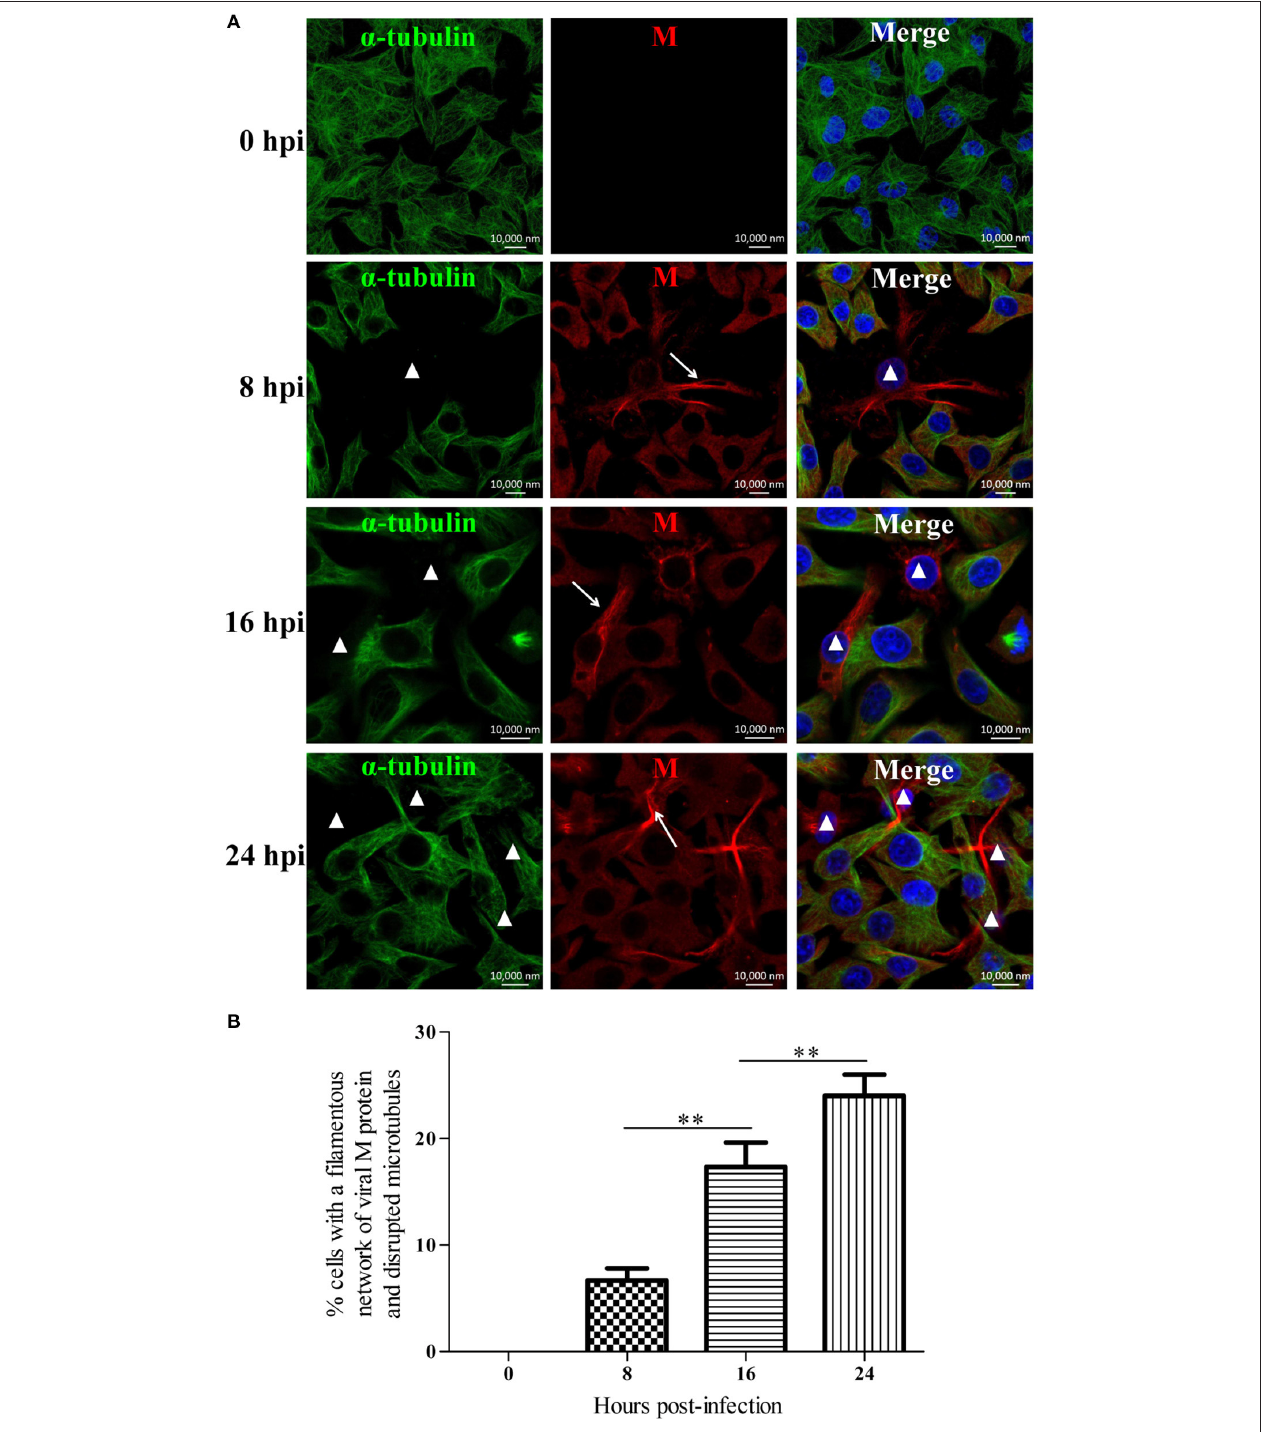
FIGURE 1 | RABV infection damages the host microtubule cytoskeleton. (A) N2a cells were infected by RABV at an MOI of 1 for 0, 8, 16, or 24h. Subsequently, the cells were fixed, permeabilized, and incubated with the anti- α -tubulin antibody (green) and anti-RABV-M antibody (red). The nuclei (Nuc) were stained with DAPI (blue). The cells were analyzed using a laser scanning confocal microscopy. The white arrows represent the filamentous network of viral M protein in RABV-infected cells and the white triangles indicate the cells which have a filamentous network viral M protein and disrupted microtubules. Scale bars, 10,000 nm. (B) Three random microscopic fields having at least 50 cells each were chosen to calculate the number of cells with a filamentous network of viral M protein and disrupted microtubules at the indicated time points. Results were expressed as percentage of viral filamentous network-positive and cellular microtubules-negative cells relative to DAPI-positive cells. Data are represented as the means ± SD ( n = 3; **represents P < 0.01).